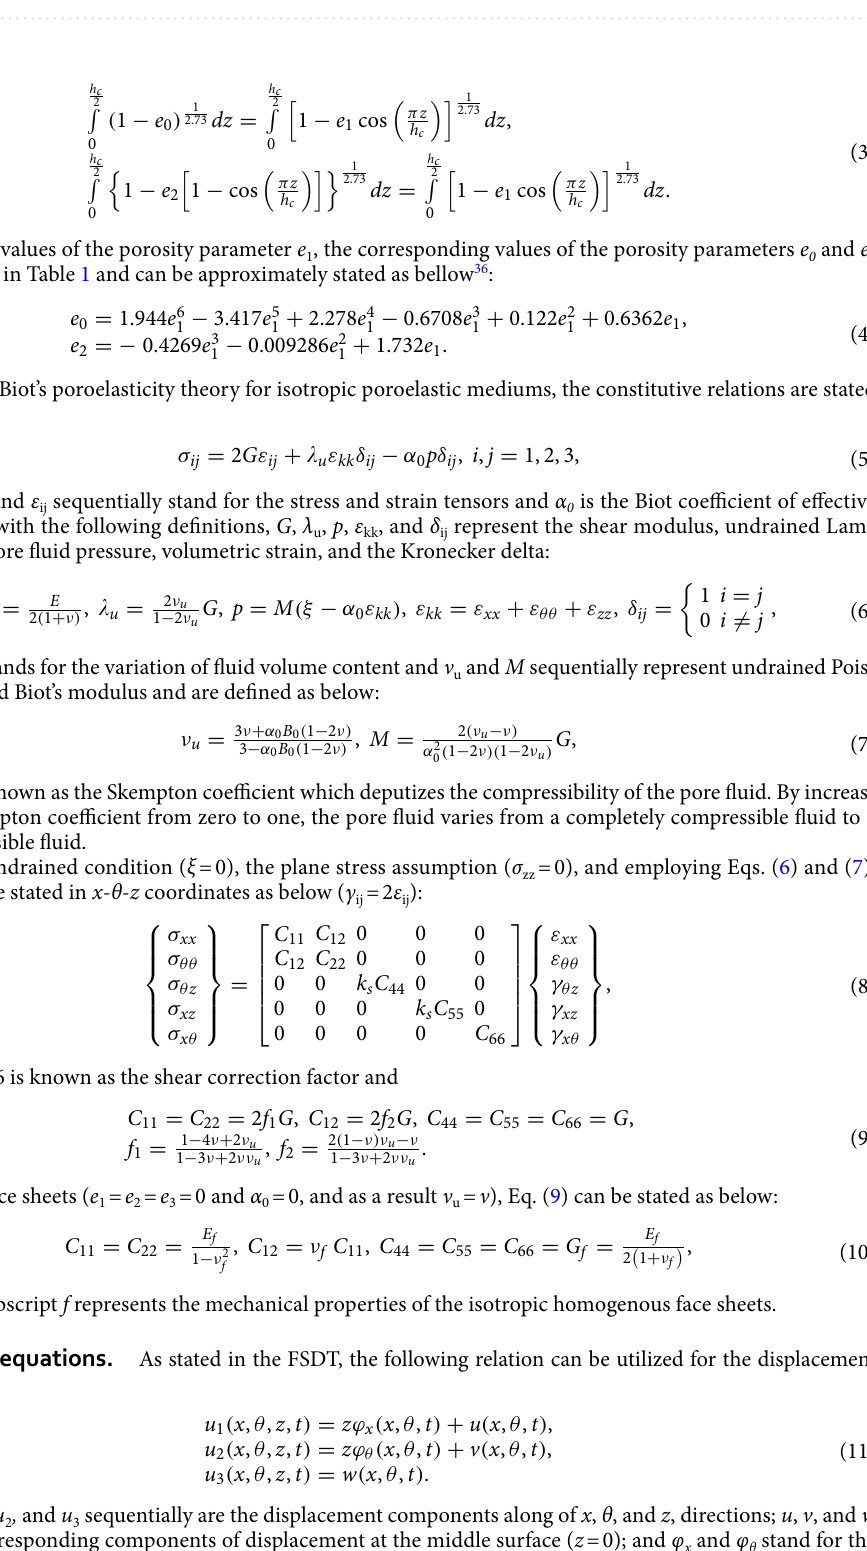
Table 1. Regulating the porosity parameters for various distributions patterns 37